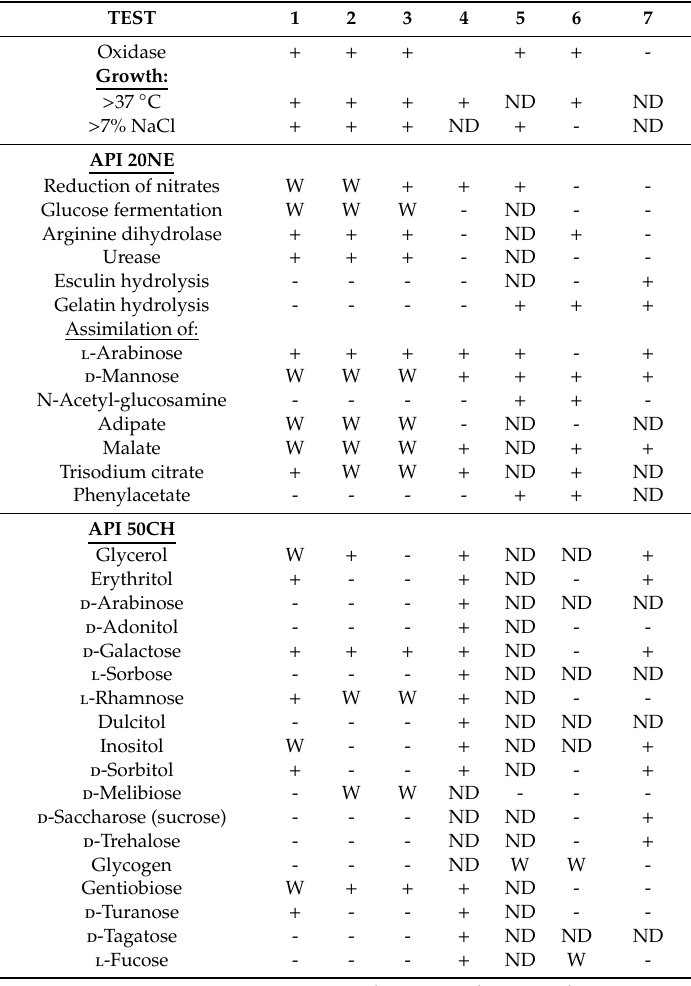
Table 6. Phenotypic di ff erences between P. typographi CA3A T (1), C2L11 (2), and C2L12B (3) (data from this study) and their closest related species P. rhizosphaerae IH5 T [55] (4), P. alkylphenolica KL28 T [56] (5), P. entomophila L48 T [51] (6), and P. congelans P 538 / 23 T [57]